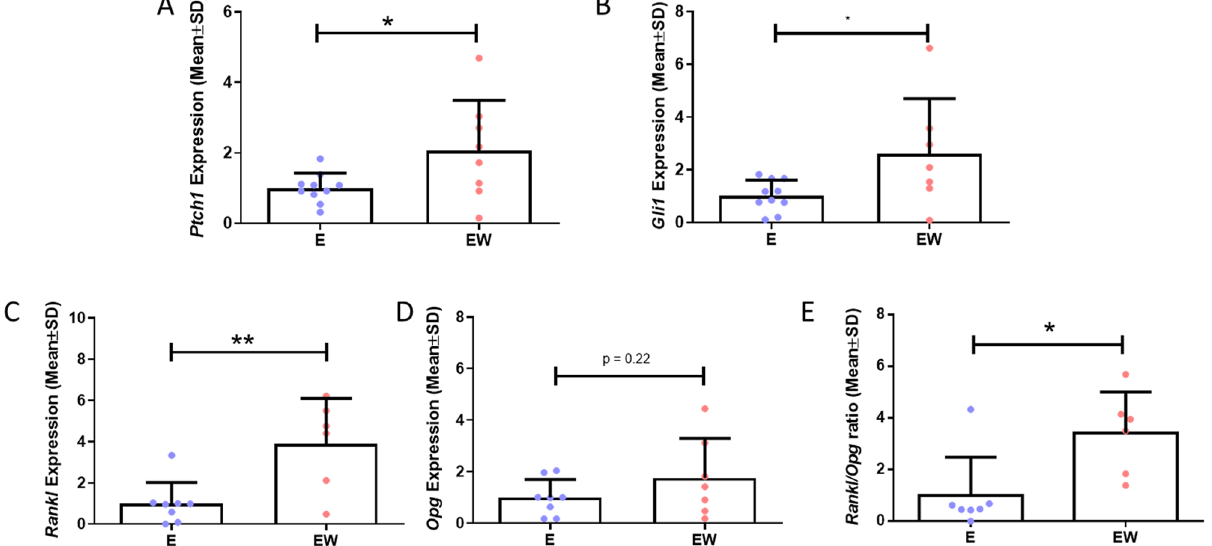
Figure 2. The effect of estrogen withdrawal on Hh and osteoclastogenic signalling. qRT-PCR results of (A) Ptch1 expression (N = 8–10), (B) Gli1 expression (N = 9–10), (C) Rankl expression (N = 6–8), (D) Opg expression (N = 7–8), and (E) Rankl / Opg ratio (N = 6–7). (Student’s t-test, *p < 0.05, **p <